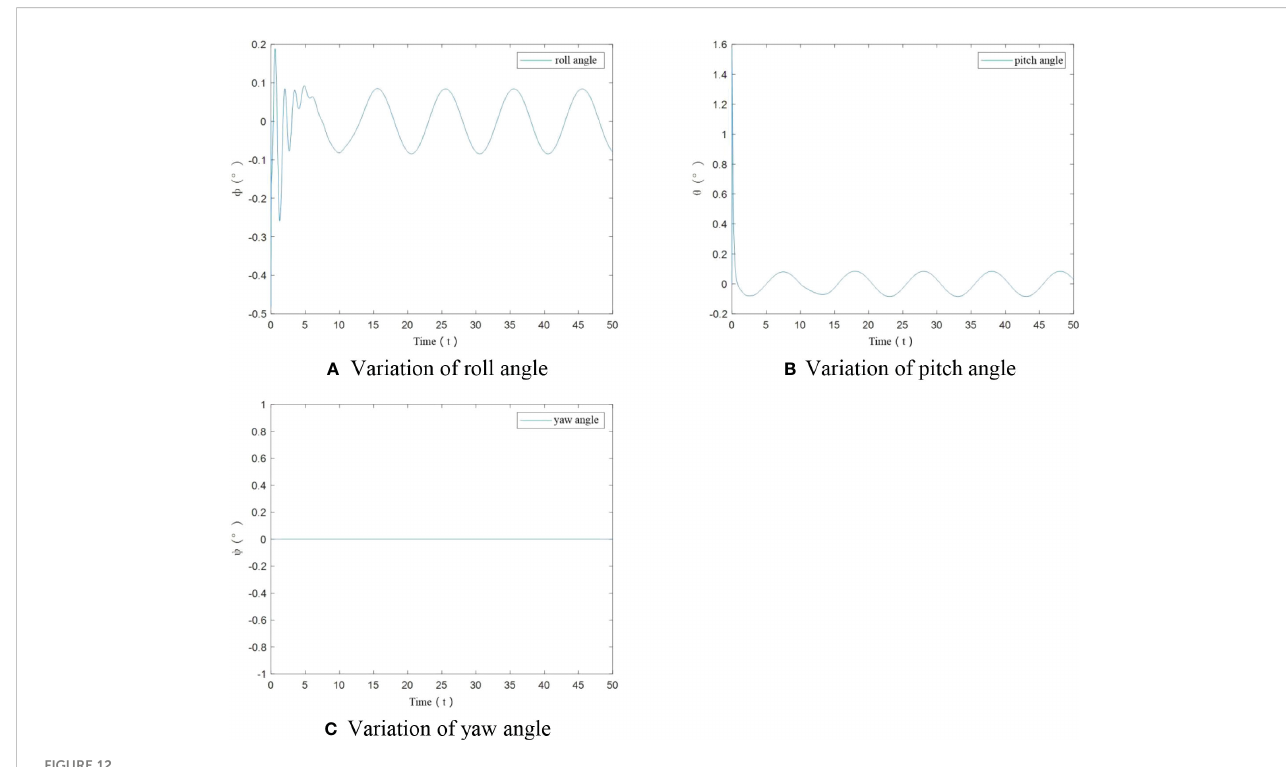
FIGURE 12 Angle variation of UAV under signi fi cant load.